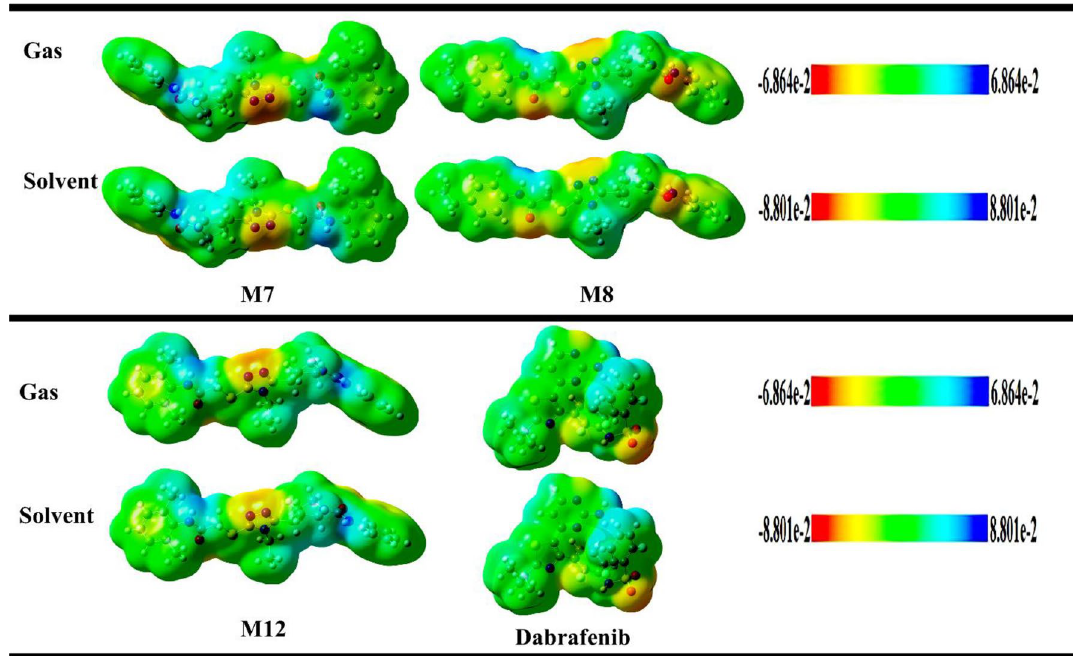
Figure 5. Electrostatic potential of most potent derivatives and